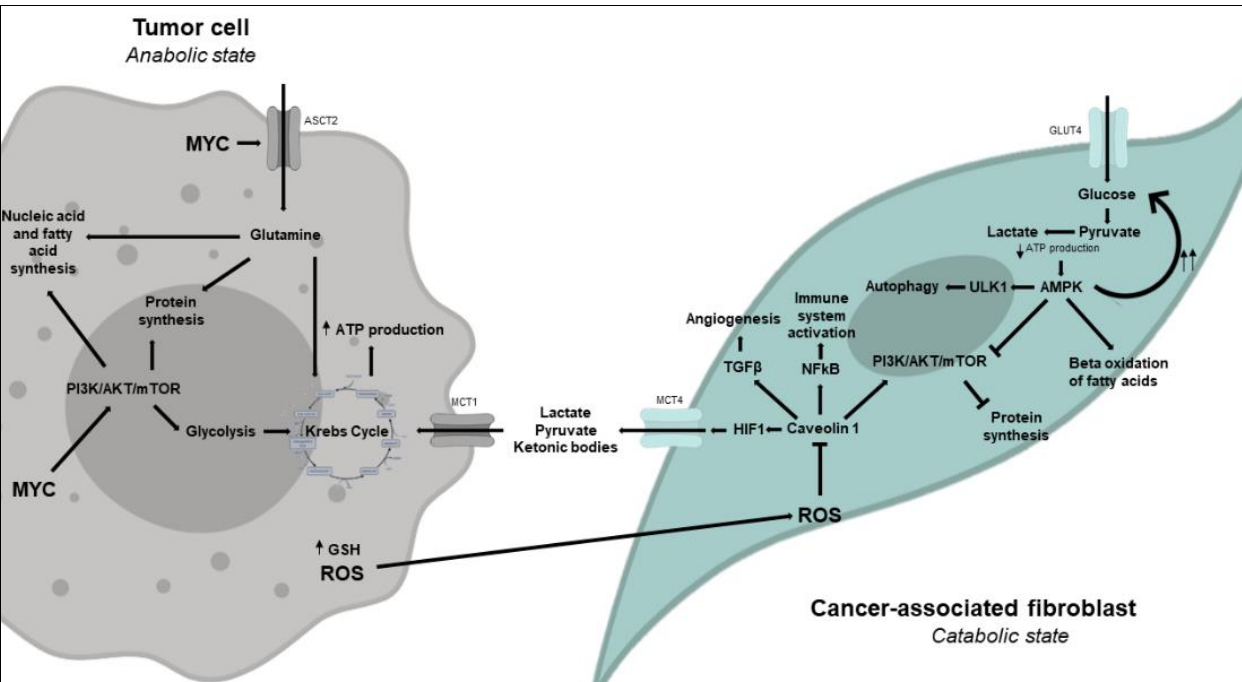
Figure 3. Schematic representation of the coupling model or reverse Warburg effect. The coupling model proposes the integration of the various metabolic changes observed in cancer in a more functional manner. This model is based on the premise that most human tumors, such as those of the breast, stomach, and pancreas, are comprised of stroma. The Warburg effect preferentially occurs in the predominant stromal cell type, i.e., the CAFs, where it manifests as an increase in aerobic glycolysis and a hypofunctional tricarboxylic acid (TCA) cycle. This leads to a significant release of lactate and ketone bodies into the interstitium and their capture by tumor cells. Once inside the cells, these molecules feed and enhance TCA activity. Likewise, the activation of autophagy in CAFs releases a large quantity of amino acids into the interstitium, which is captured by the cells of the tumoral parenchyma for use in the anabolic synthesis of protein. Catabolic reactions, therefore, predominate in the stromal CAFs, favoring the preponderance of anabolism in the tumor cells. This is known as the reverse Warburg effect or the coupling model. Upward pointing arrows indicate increased levels or activity of that molecule or pathway. The downward pointing arrows indicate the opposite. Created using BioRender.